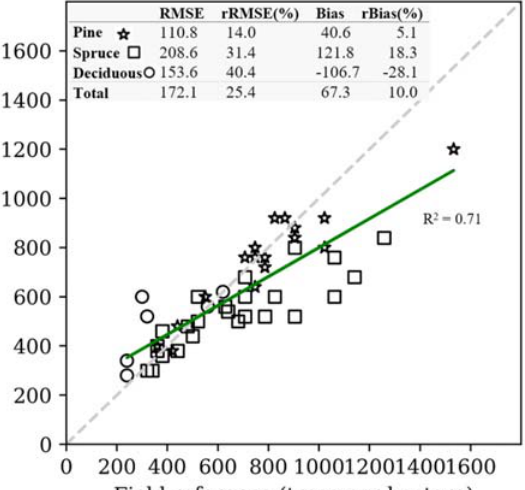
Figure 6. Tree density estimation (trees per hectare, TPH) using watershed segmentation method with LML data per each and all species classes.